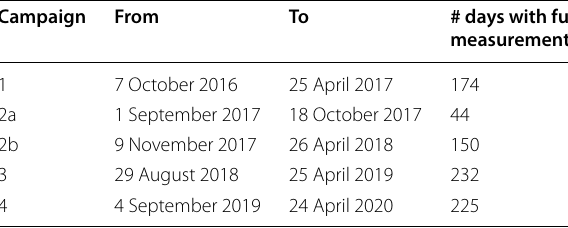
Table 1 Kannuslehto campaigns used in the present study Campaign